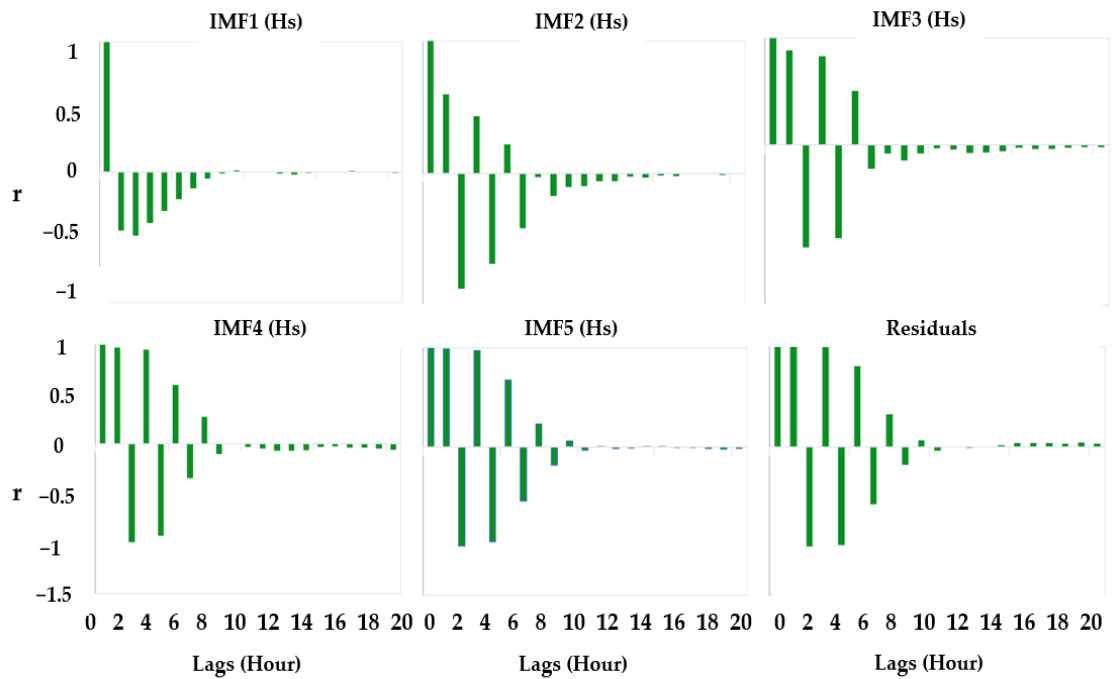
Figure 3. Partial autocorrelation function (PACF) plot of the Hs time series exploring the antecedent behaviour in terms of the lag of Hs in hours.